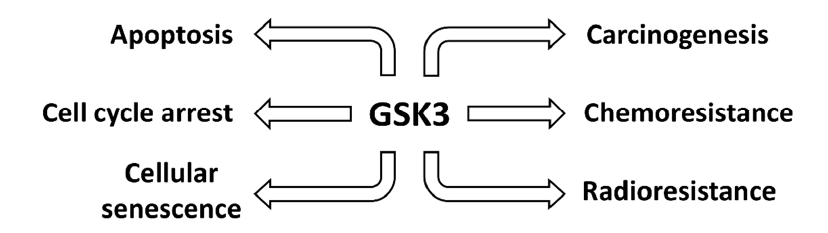
Figure 2. Effects of GSK-3 on Various Cancers . Aberrant GSK-3 expression can influence the development and progression of human